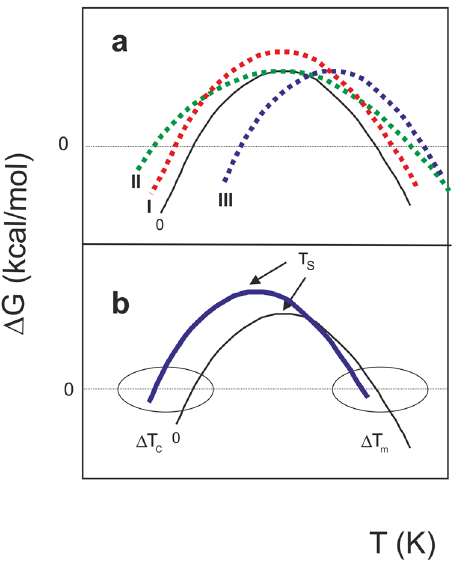
Fig. 3 Mechanisms that in fl uence stability curves of a protein. a Dependence of the difference of free energy between unfolded and folded states ( Δ G ) of a hypothetical protein vs temperature ( T ) (curve 0). Mechanism I illustrates the effect of increasing Δ H S (curve I). Mechanism II shows the effect of reducing Δ C p (curve II). Mechanism III shows the shift of the whole stability curve towards higher temperatures caused by decreasing Δ S m (curve III). b A combination of the three mechanisms. The solid blue curve, with a prevalent low shift of T S , corresponds qualitatively to the cases of Yfh1 reported in Fig. 1d. The fi gure was adapted from